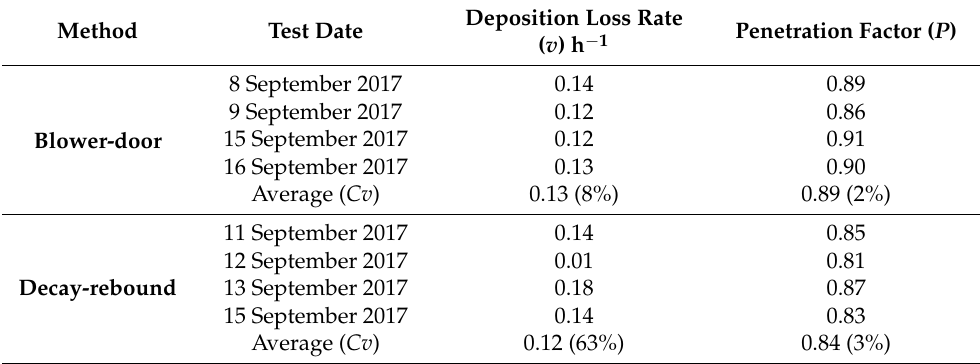
Table 2. Deposition rate ( v ) and penetration factor ( P ) of four replicate tests with the coefficient of variation ( Cv )